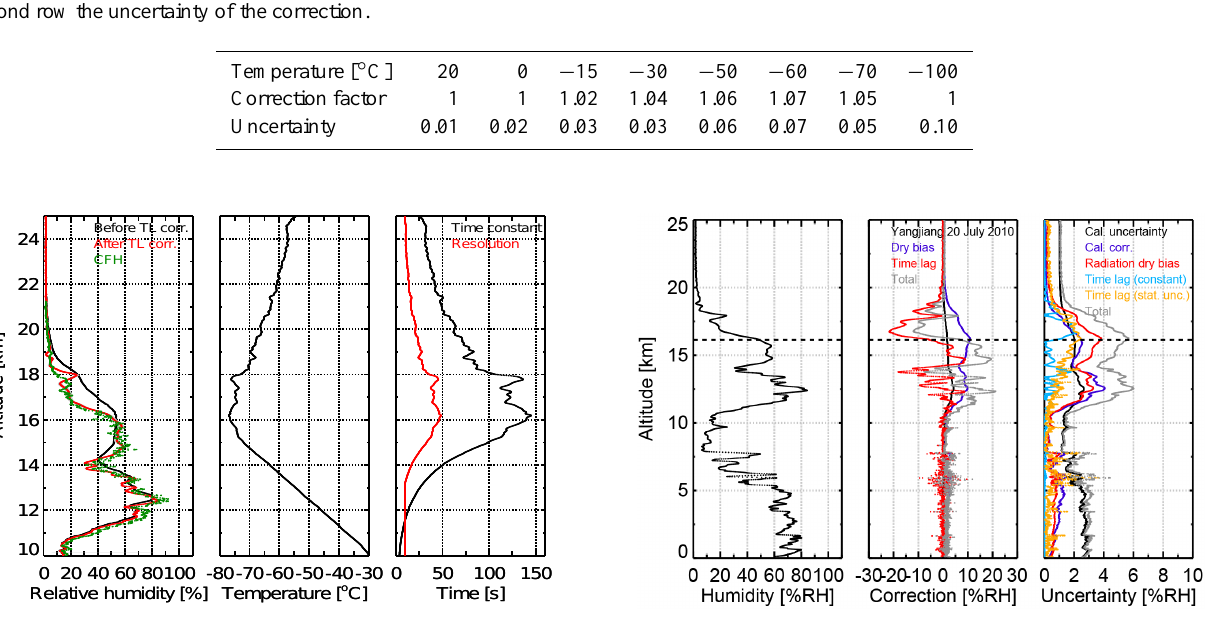
Figure 15. Effect of time-lag on the RS92 humidity profile. Left panel: comparison of RS92 humidity profile before (black) and after (red) GRUAN time-lag correction, and coincident CFH profile (green). Middle panel: temperature profile from RS92. Right panel: the time-lag constant τ (black) and the time-resolution of the humidity profile after the filtering by the time-lag correction algorithm (red). The sounding was performed in Yangjiang on 20 July 2010.